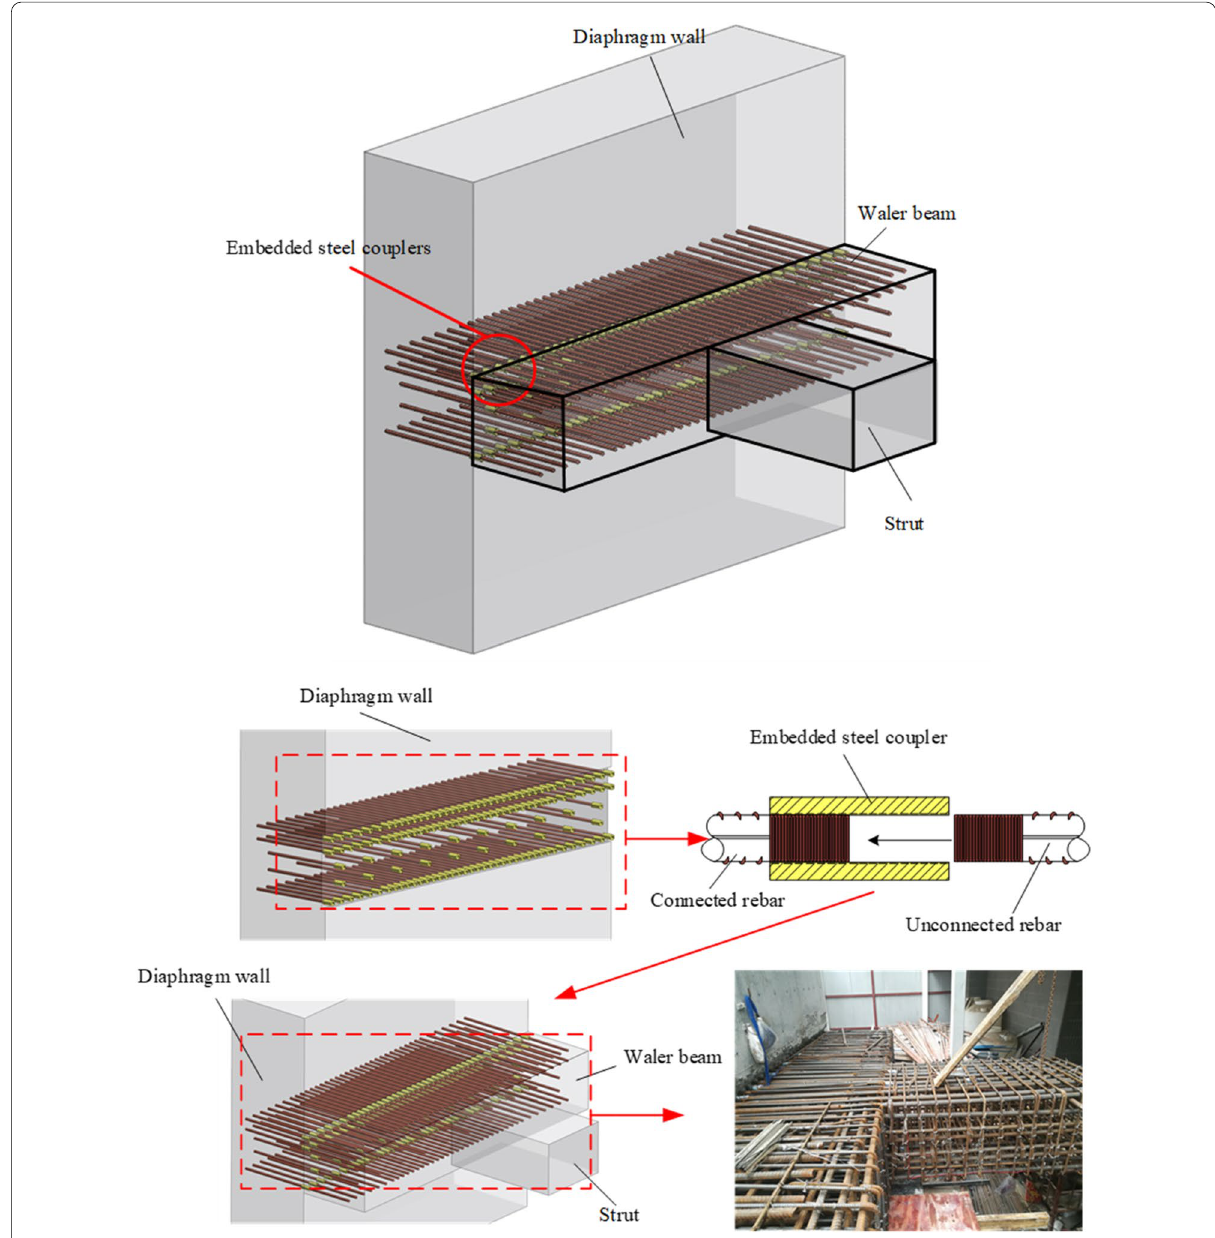
Fig. 2 Embedded steel coupler